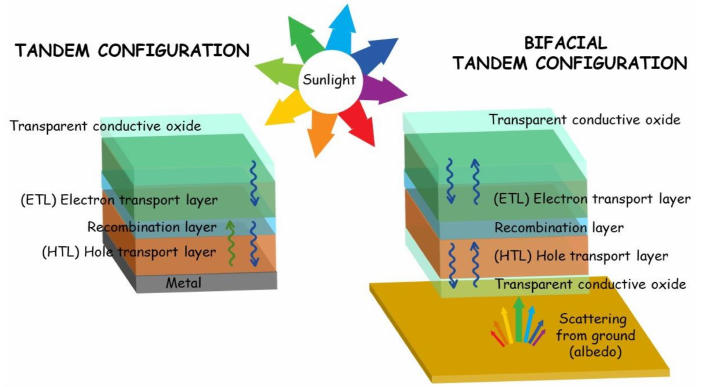
Figure 9. Scheme of tandem and bifacial tandem